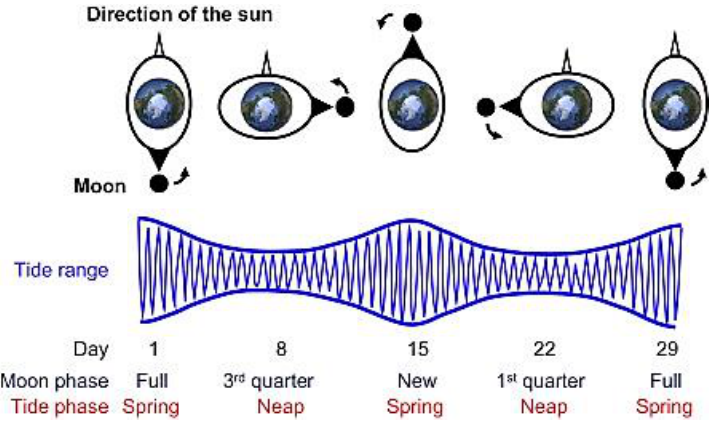
Figure 3. Spring tide and neap tide.